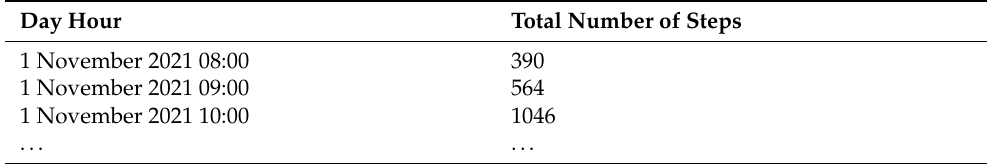
Table 1. Example of total number of steps per